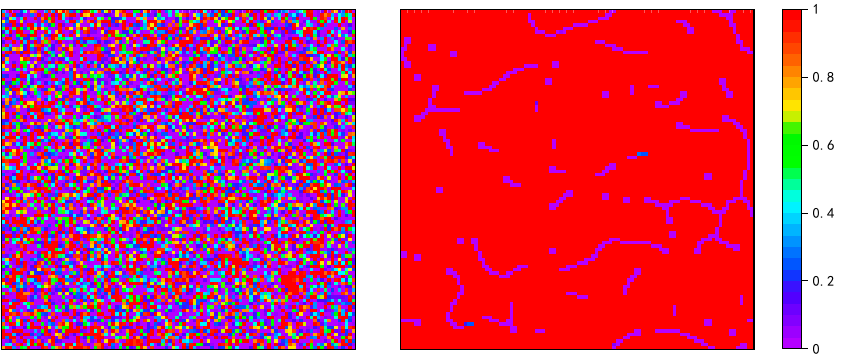
Figure 6. Public goods game at 𝑟 = 4.0 and 𝜔 = 0.99 with 𝛼 = infinite ( left ) and 𝛼 = 3 ( right ), respectively. Snapshots were obtained at time step 50,000. The color encoding, as depicted at the right of each chart, indicates the values of 𝐼 (cid:3036) for each individual.